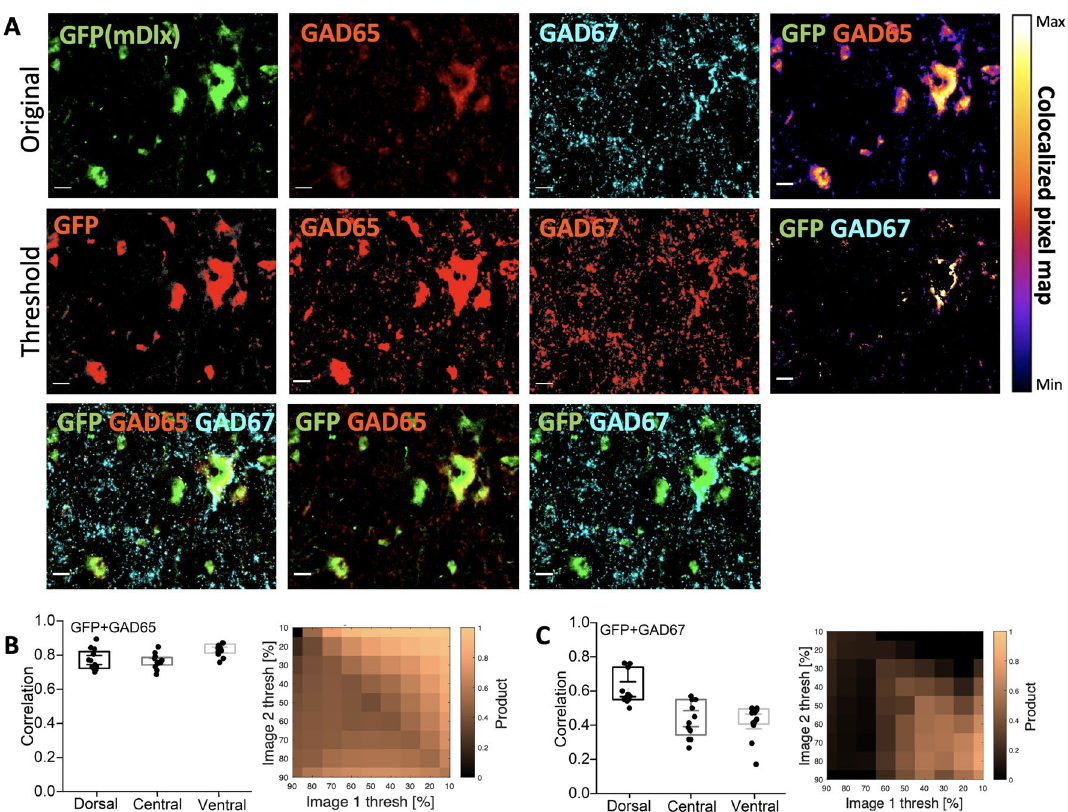
Figure 3. AAV2-mDlx has expression in GABAergic neurons, specifically the GAD65+ neurons. ( A ) Top row: original images of mDlx reporter (GFP, green) and GAD65 (red) and GAD67 (cyan) and a colocalization pixel map of GFP/GAD65 (right). Middle row: thresholded versions of top row, with the overlap in heat map (right) (scale bar 20 µ m). Bottom row: overlap of GFP/GAD65/GAD67, GFP/GAD65 and GFP/GAD67, respectively. ( B , C ) Varying the threshold and calculating the co-localization as correlation ( C ). Note N = 4 animals, n = 3